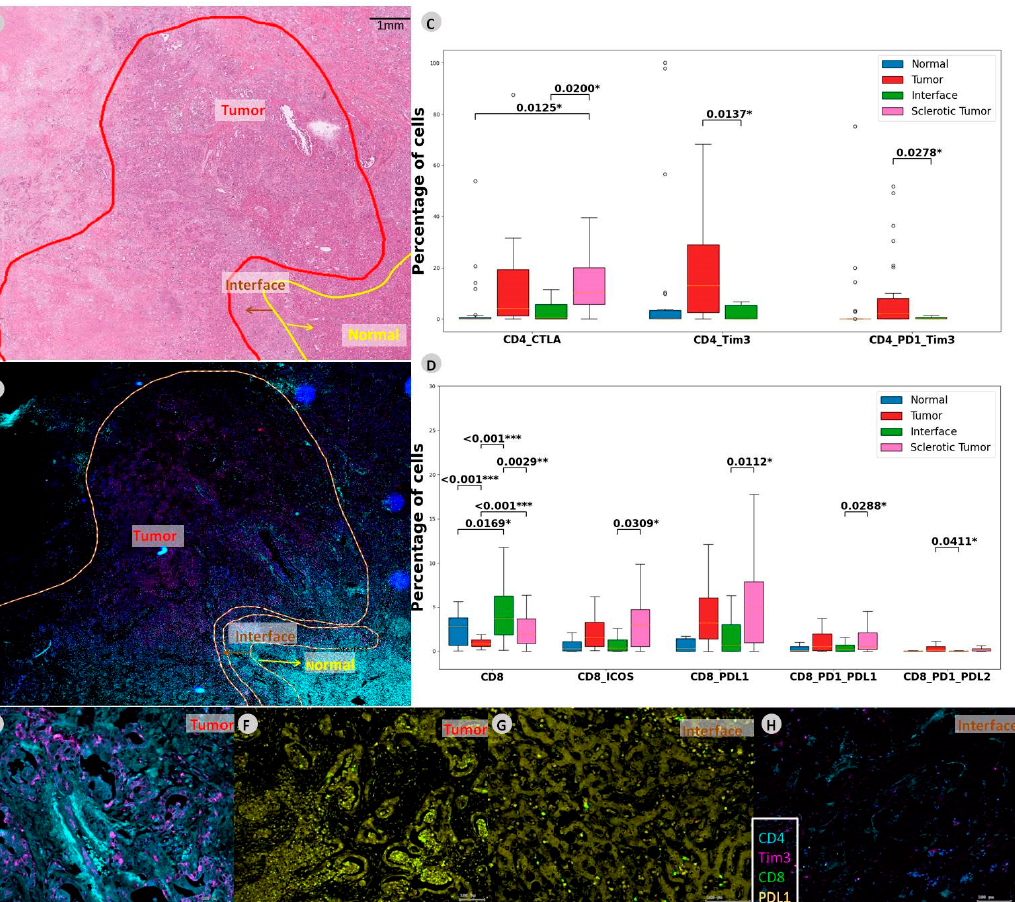
Figure 2. CD4 and CD8 co-expressions in intrahepatic CCA. ( A ) In this slide, different regions are outlined on the HE slide and ( B ) mIF slide. ( C , D ) Boxplot demonstrating abundances within the CD4 and CD8 compartments demonstrating the significant abundances of immune cells and checkpoint molecules. ( E , F ) Zoomed-in multiplexed image of the outlined tumor ROI. ( G , H ) Multiplexed image of the outlined interface ROI. Levels of significance: any p value less than 0.001 was designated with three (***) asterisks. p values between 0.001 and 0.01 are shown with two (**) asterisks and p values between 0.01 and 0.05 are shown with one (*) asterisk. CCA: cholangiocarcinoma, iCCA: